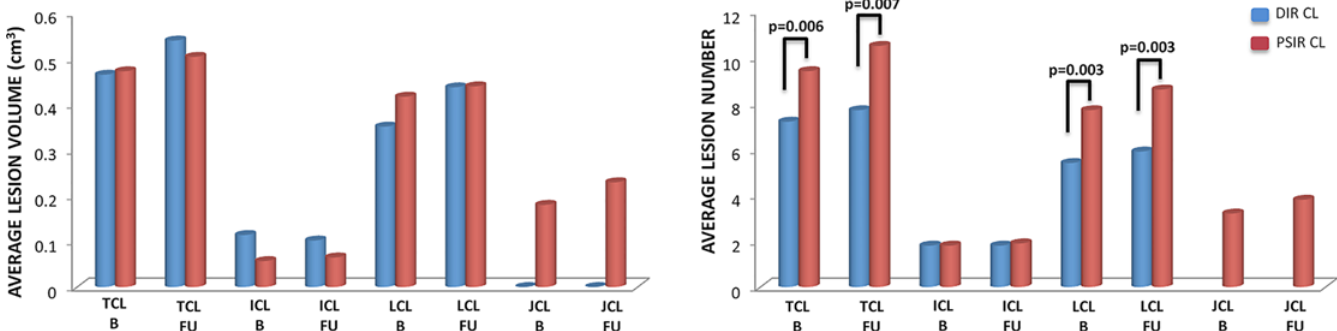
Fig 1. Baseline and follow-up DIR and PSIR cortical lesion volumes and numbers. At baseline (B) no statistically significant differences were detected between DIR and PSIR cortical lesion volumes while differences were found in cortical lesion numbers. PSIR detected a higher number of cortical lesions and leucocortical lesions compared to DIR. Similarly; at follow-up (FU) no statistically significant differences were detected between DIR and PSIR cortical lesion volumes, while differences were found in cortical lesion counts. PSIR detected a higher number of cortical lesions and leucocortical lesions compared to DIR. Furthermore, PSIR at both time points detected juxtacortical